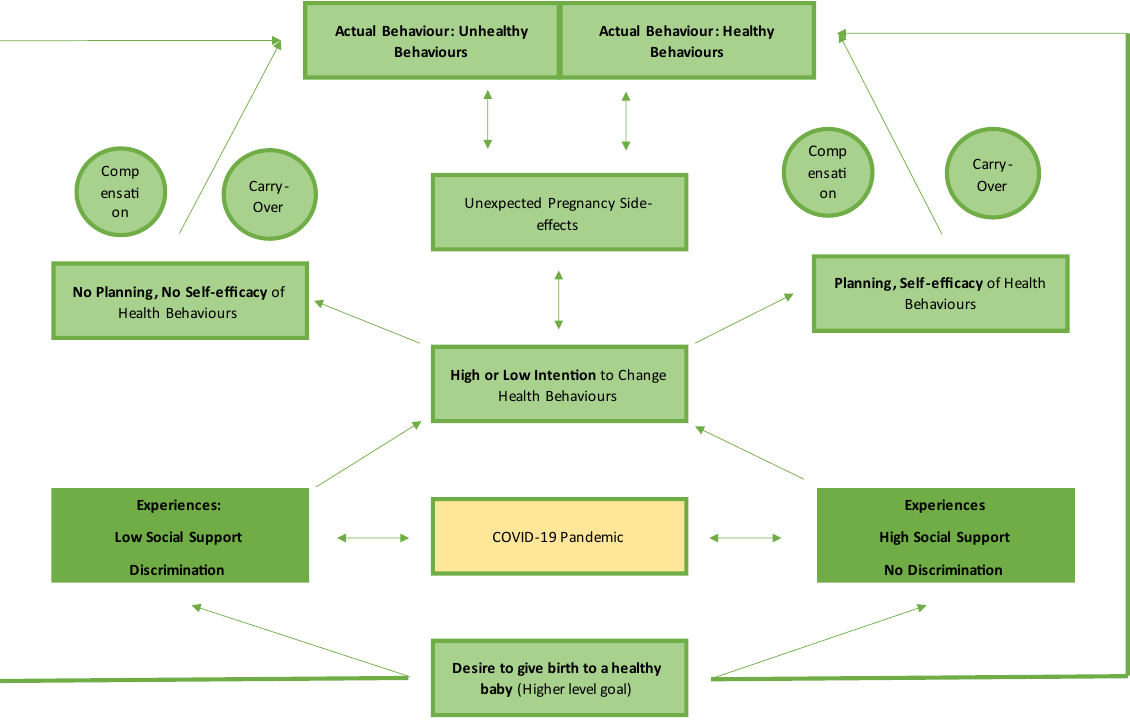
Figure 2. The findings of this study integrated into the Compensatory Carry-Over Action Model.